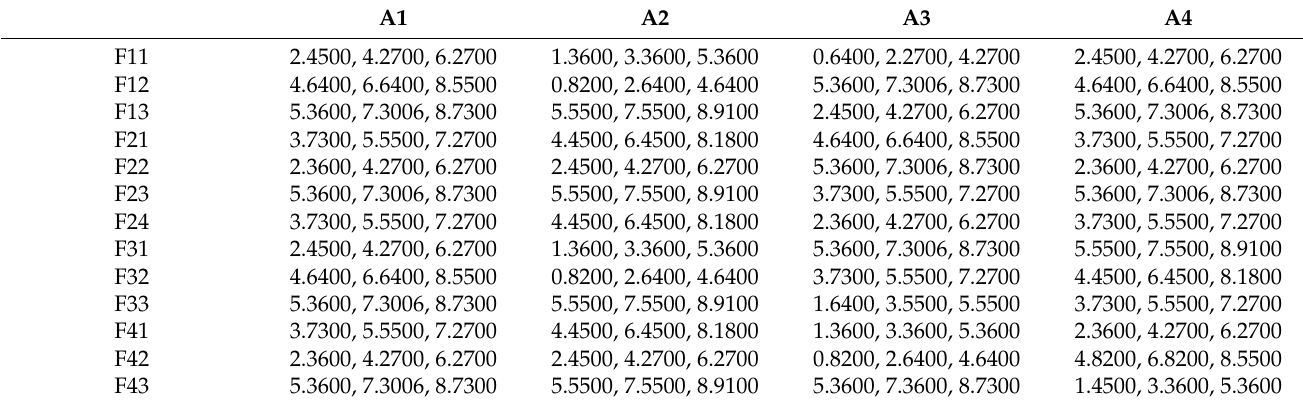
Table 3. Subjective cognition results of evaluators in linguistic terms.